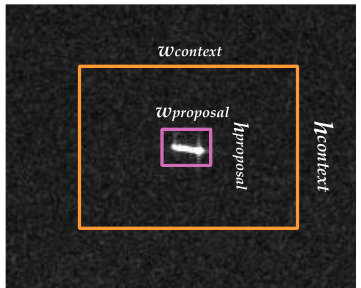
Figure 4. An illustration of context information. The bounding box in purple represents the region proposal of the network and the outer orange bounding box is the boundary of context information.